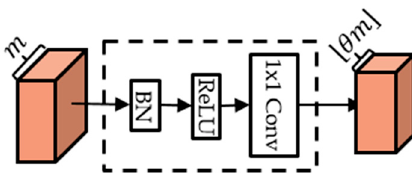
Figure 3. Compression block.